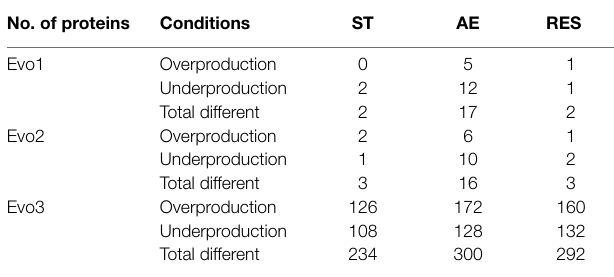
TABLE 3 | Common proteins overproduced in all mutants compared to MG1363 under aerated conditions. Protein ID Protein name/Gene GO terms and functions name (GN) A2RIN9 donors, NAD or NADP as acceptor. GN = gapA